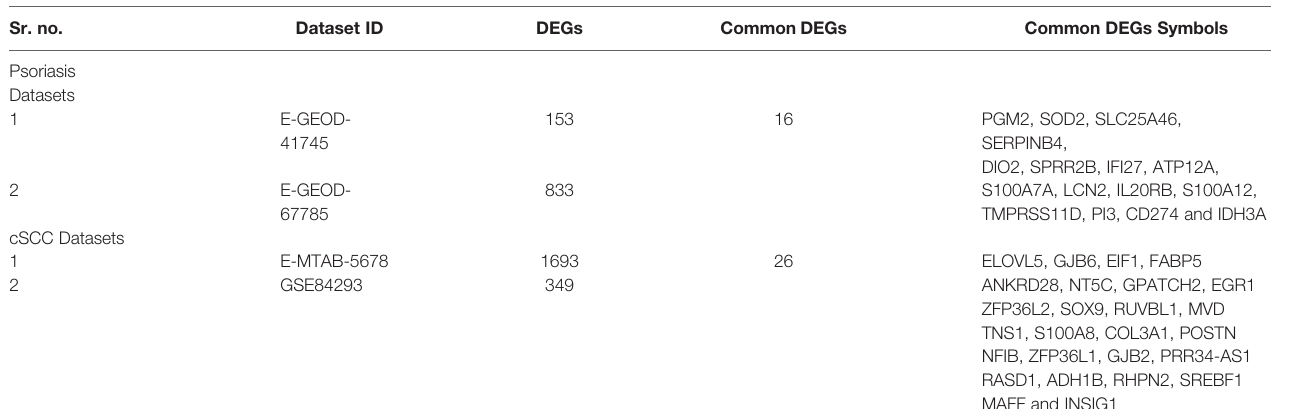
TABLE 3 | Number of identi fi ed and symbols of common DEGs of RNA-seq datasets. Sr.